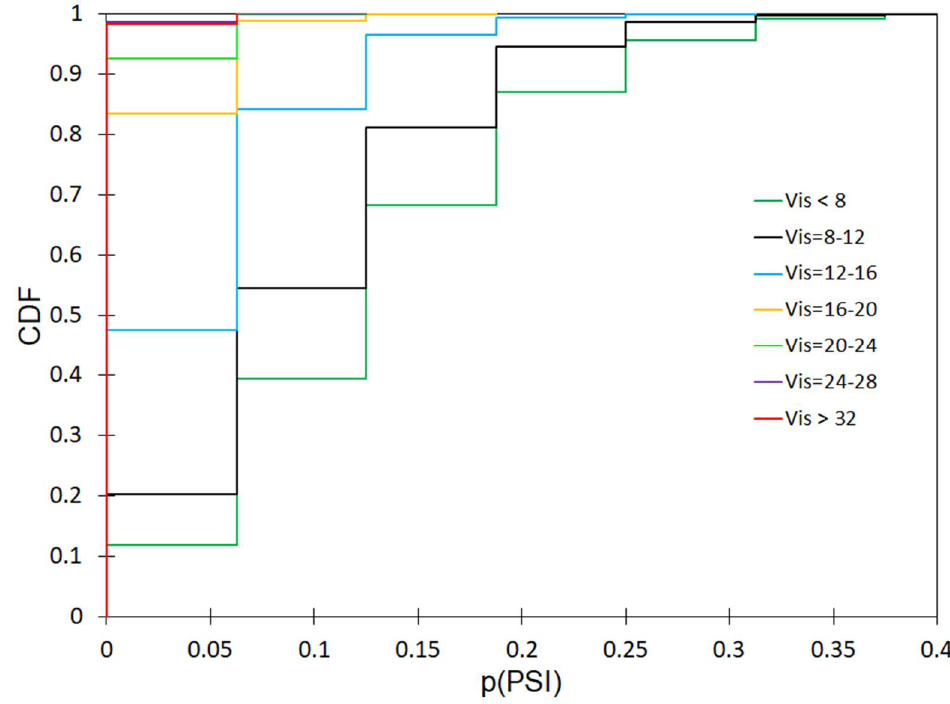
Figure A29. Effect of visibility on the incidence of mean winter mortality for rainy days.